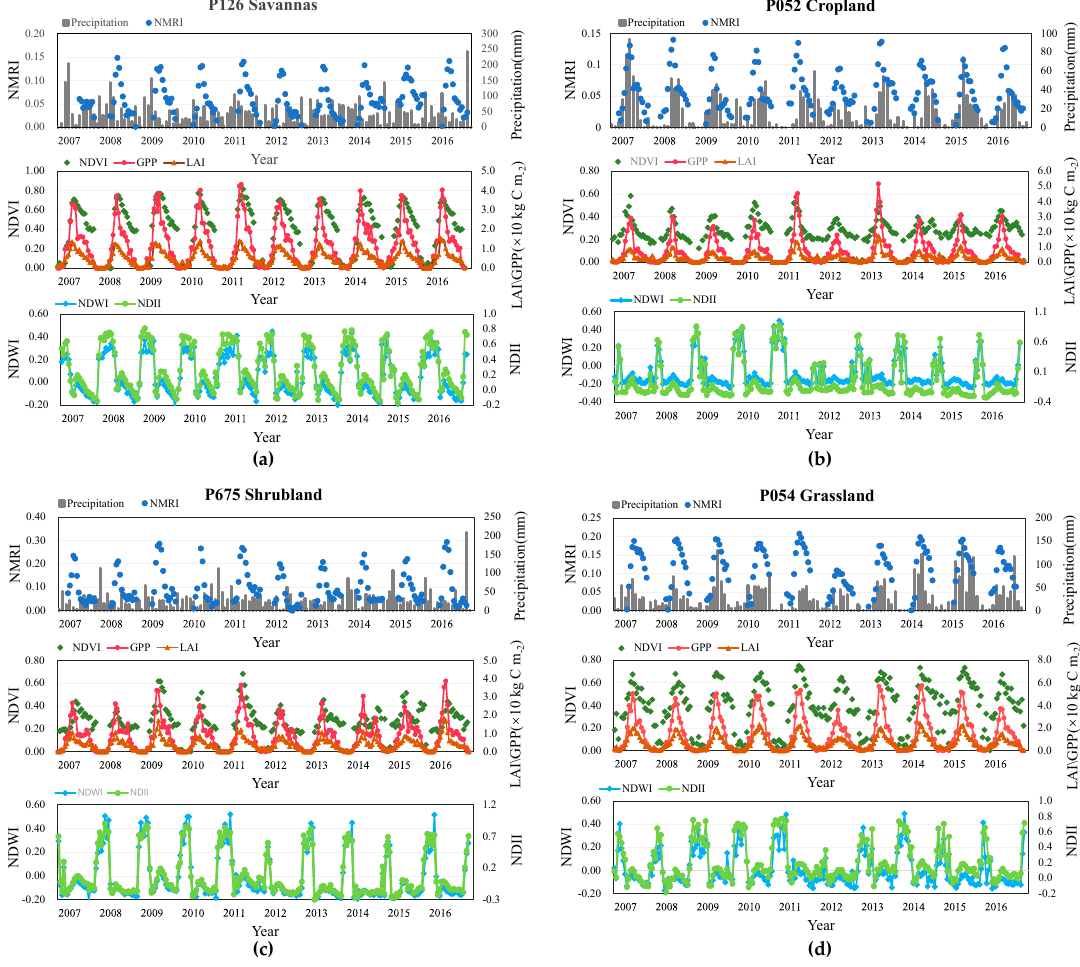
Figure 4. The long time-series variation diagrams of the seven indices over the four vegetation types: ( a ) Savannas; ( b ) cropland; ( c ) shrubland; ( d ) grassland.